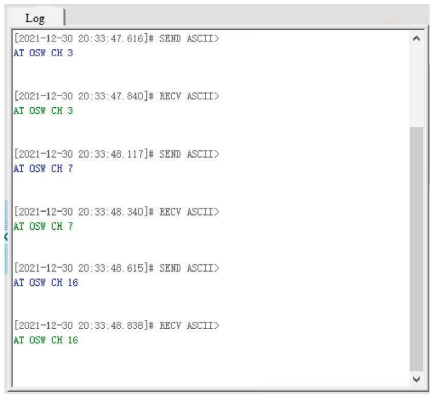
Figure 14: Logs of optical switch that is switched based on the predicted result.